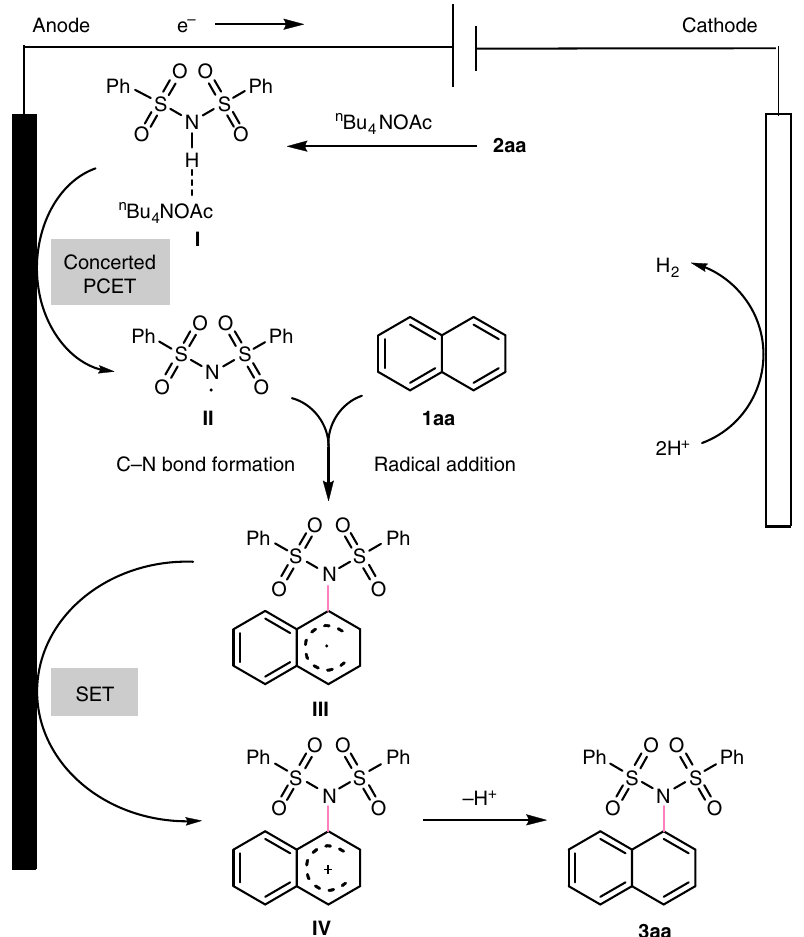
Fig. 9 Proposed mechanism of electrochemical oxidation-induced intermolecular aromatic C – H imidation. A plausible mechanism involves the homolysis of the N – H bond to afford intermediate II , subsequent radical addition, single electron oxidation, and deprotonation to form the desired product 3aa . Protons undergo cathodic reduction to generate